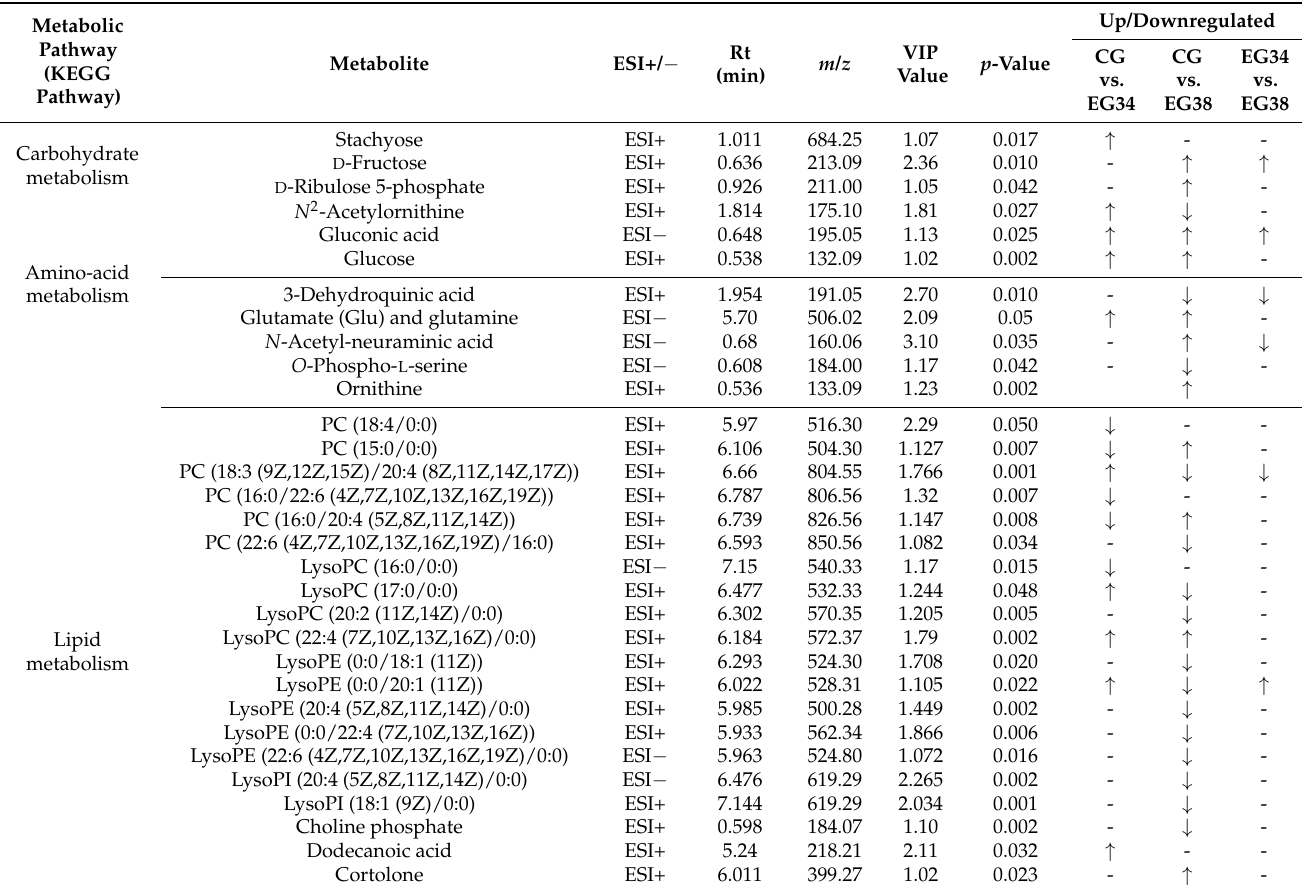
Table 1. Significantly different